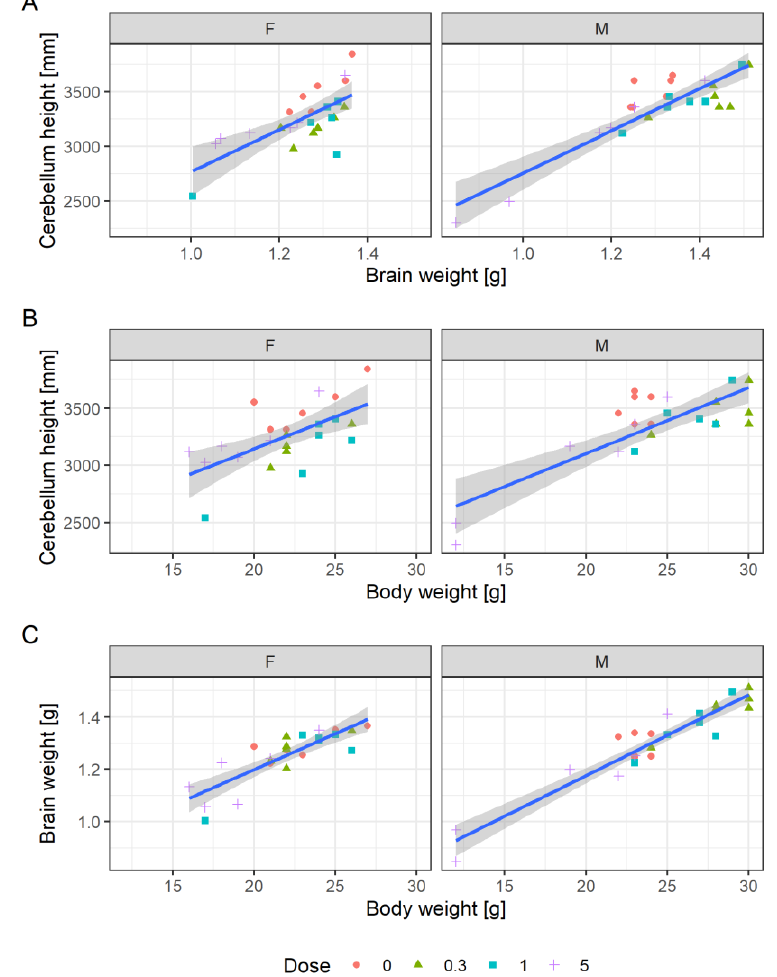
Figure 7: ( A ) Cerebellum height to brain weight, ( B ) cerebellum height to body weight, and (C) brain weight to body weight scatter plot, overplotted with linear models. The dose levels are depicted as sym-